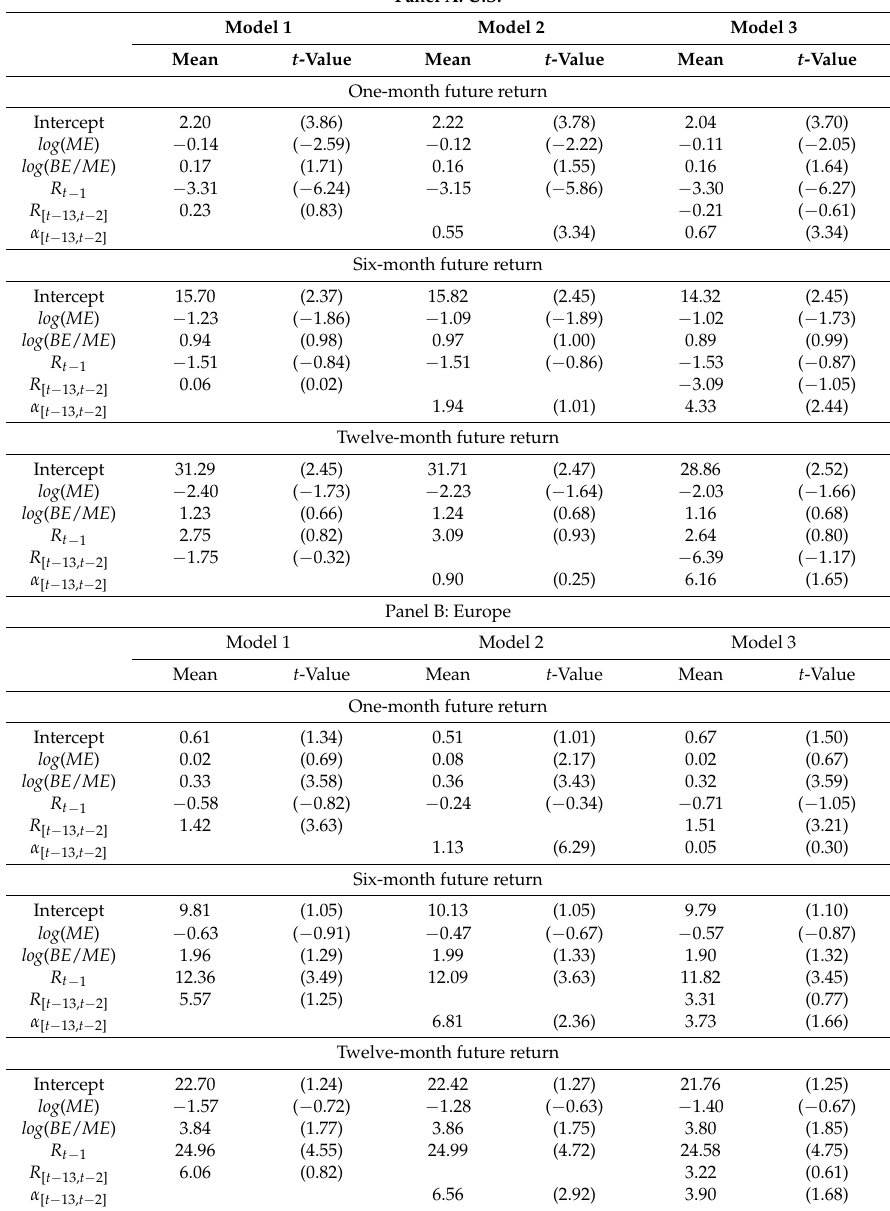
Table 1. Monthly cross-sectional regressions of individual stock returns based on past return and past